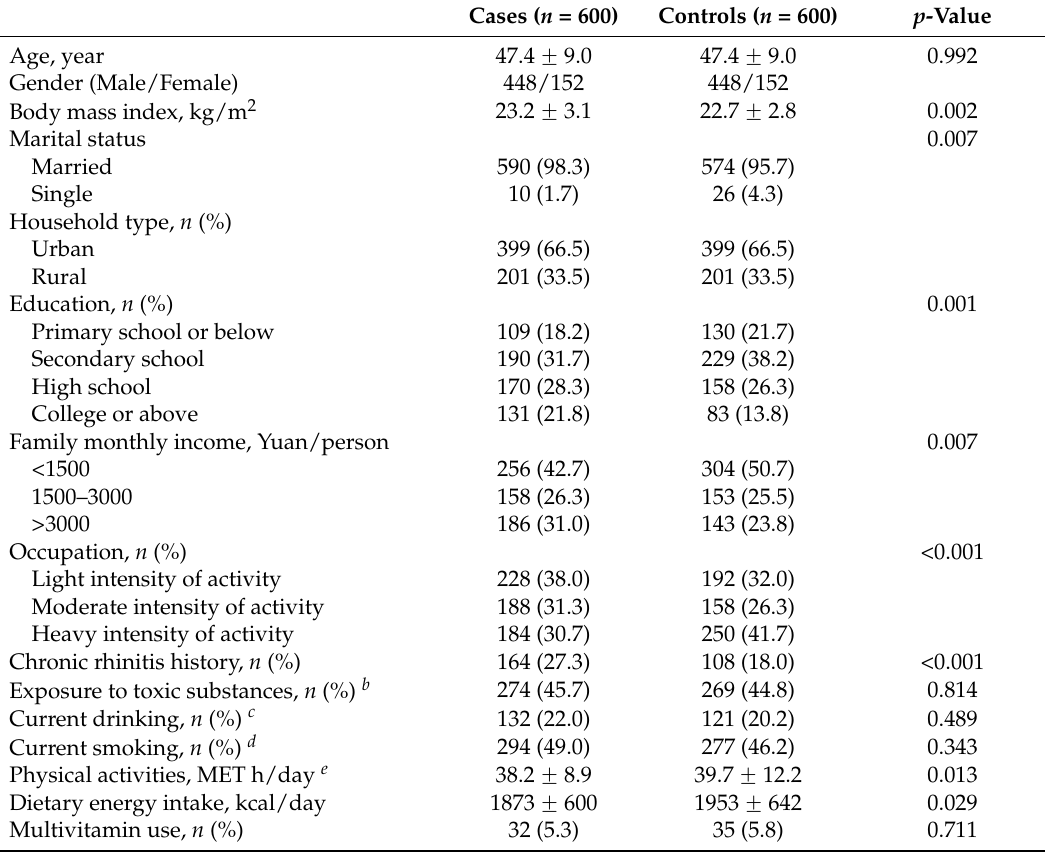
Table 1. Participants’ characteristics in nasopharyngeal carcinoma cases and controls a . Cases ( n =